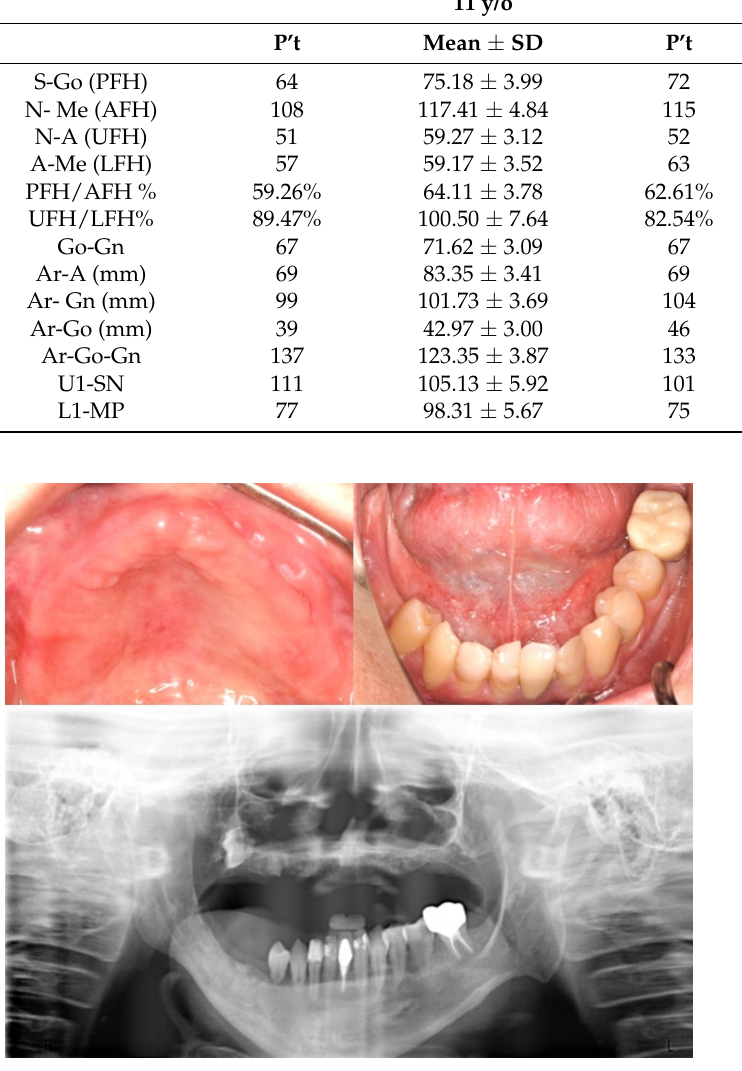
Figure 5. The patient lost multiple teeth and suffered severe facial deformity 25 years after the pediatric rhabdomyosarcoma (RMS) cancer therapy.